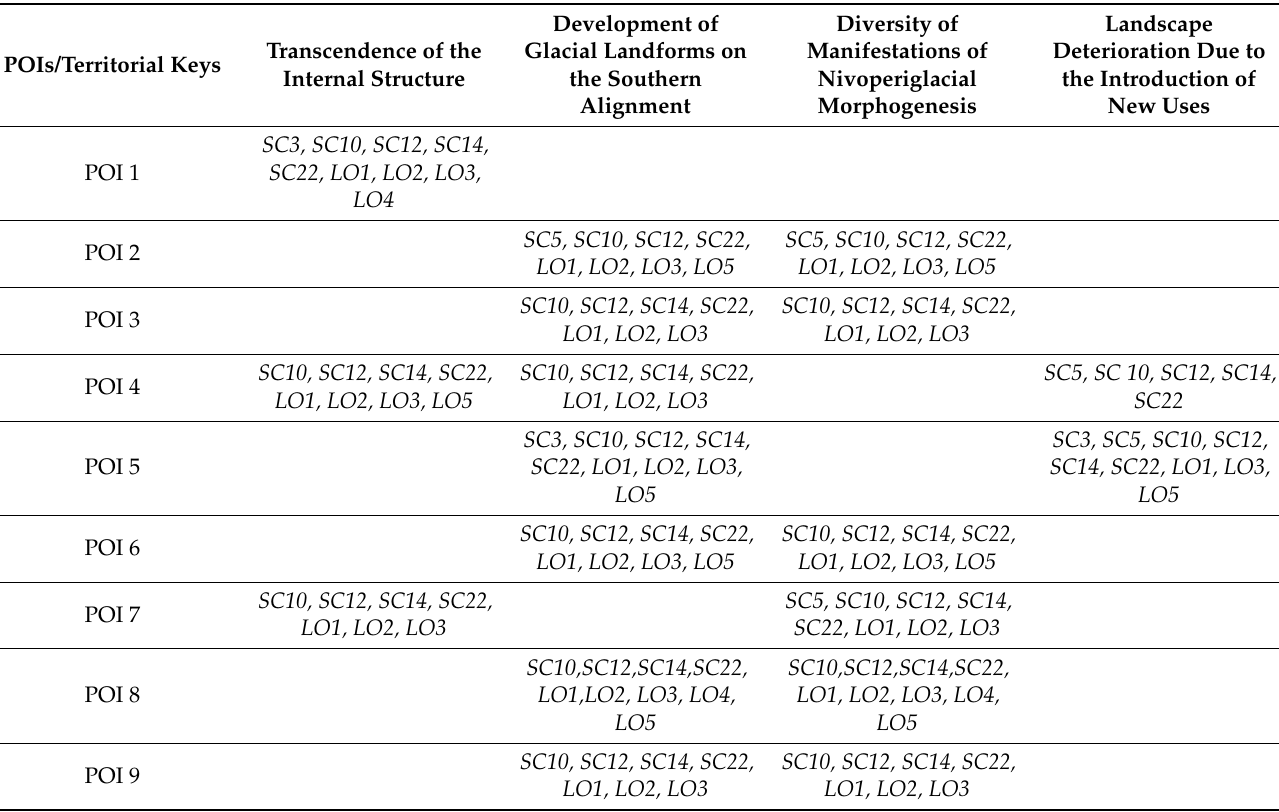
Table 3. Usefulness of the itinerary according to the key competences and learning results of